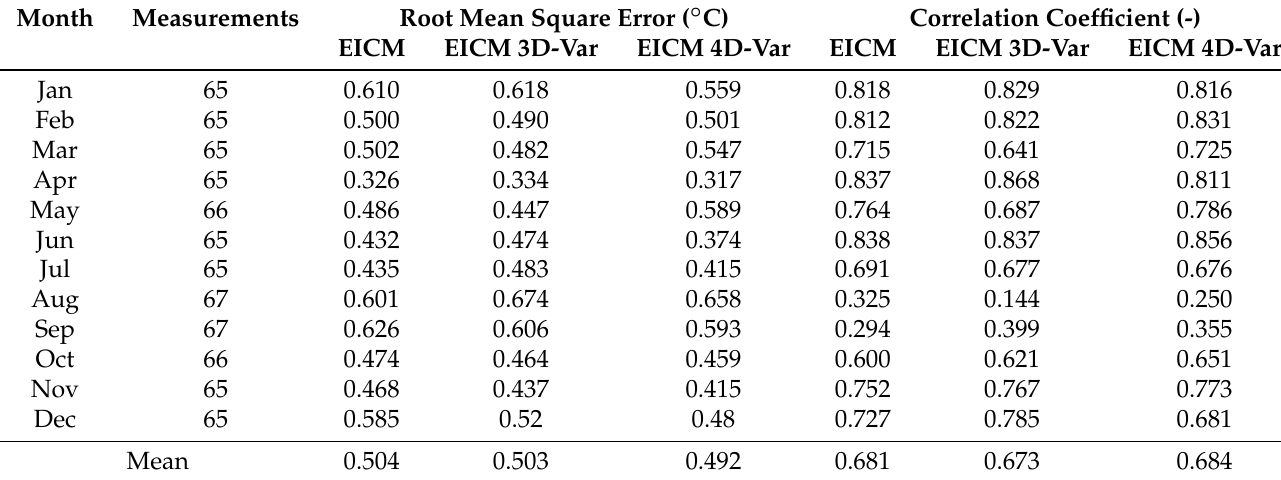
From Table 1, it was found that the RMSE values of all three simulations had little difference, because comparison with statistical data takes the data one month in advance. When comparing the three-month, six-month, and nine-month prediction results, it was found that the RMSE value varied more. The three-month forecast had a difference of 0.02 for RMSE. The six-month and nine-month forecast had a difference of RMSE is 0.07, as shown in Table